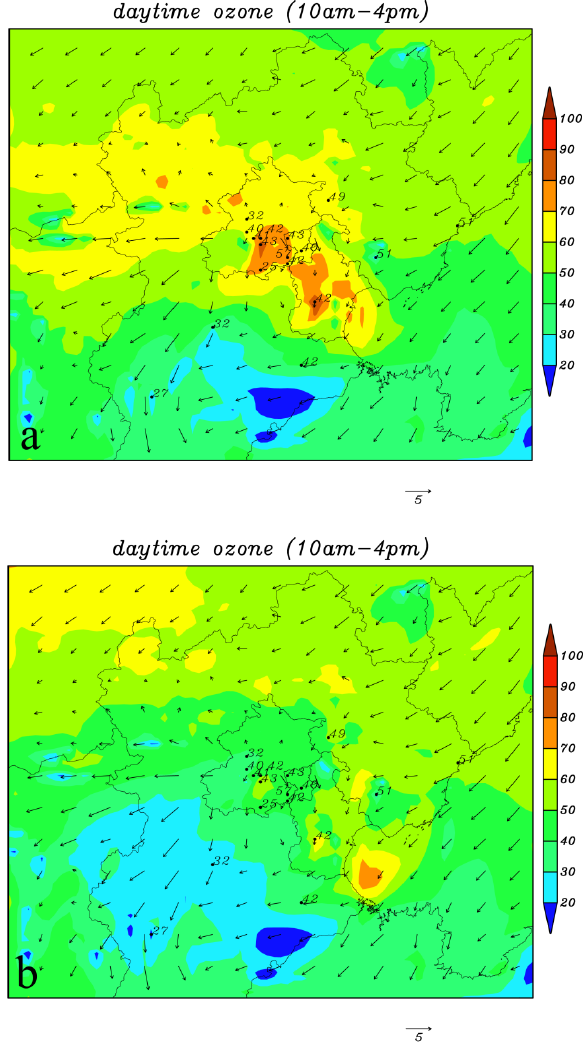
Fig. 2. Simulated daytime ozone concentrations (ppbv) on August 14 in the third domain obtained from (a) free run and (b) EXP1. The observed daytime ozone values (numbers near dots) at monitoring stations are also shown.